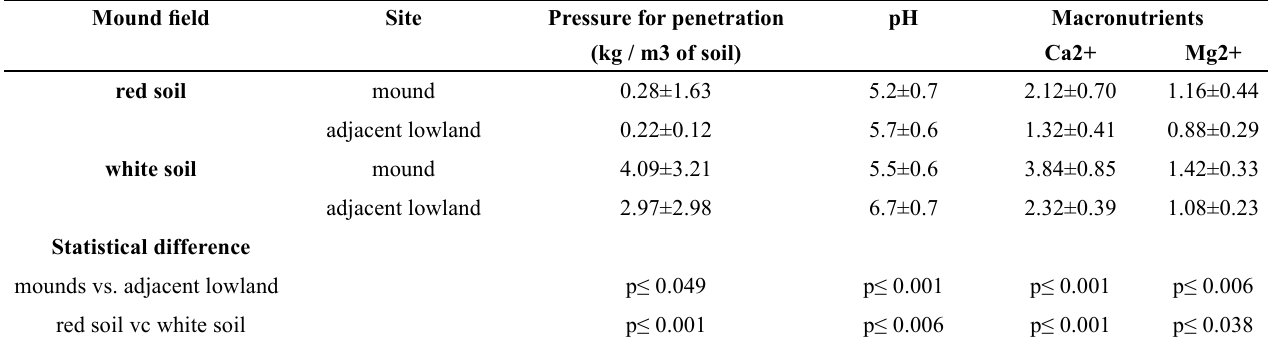
Table 2 . Physicochemical characteristics of the soil in the mounds fields from Caatinga ecosystem, northeastern Brazil.